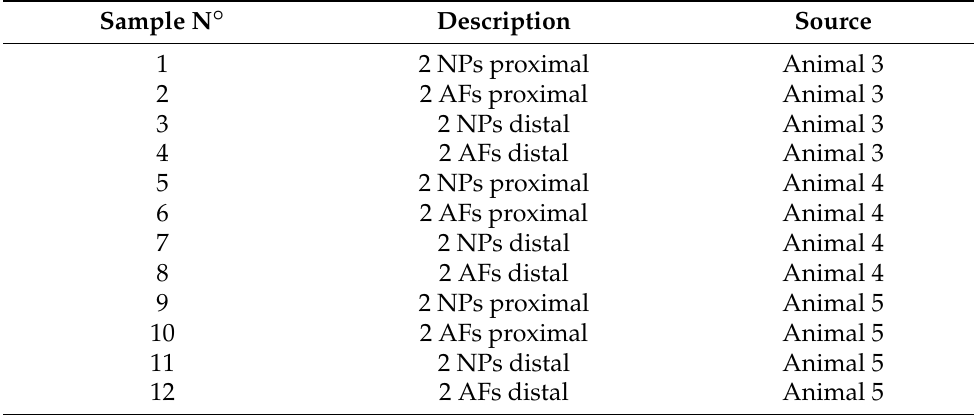
Table 2. Samples bulk sequencing. List of samples used for bulk RNA